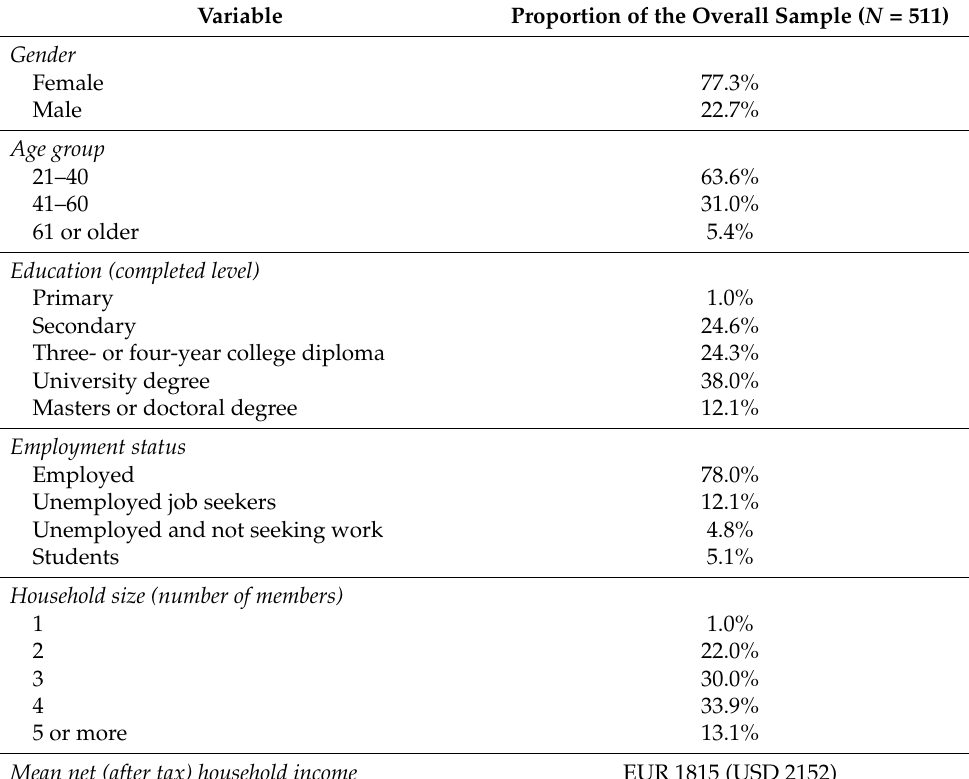
Table 1. Demographic characteristics of the